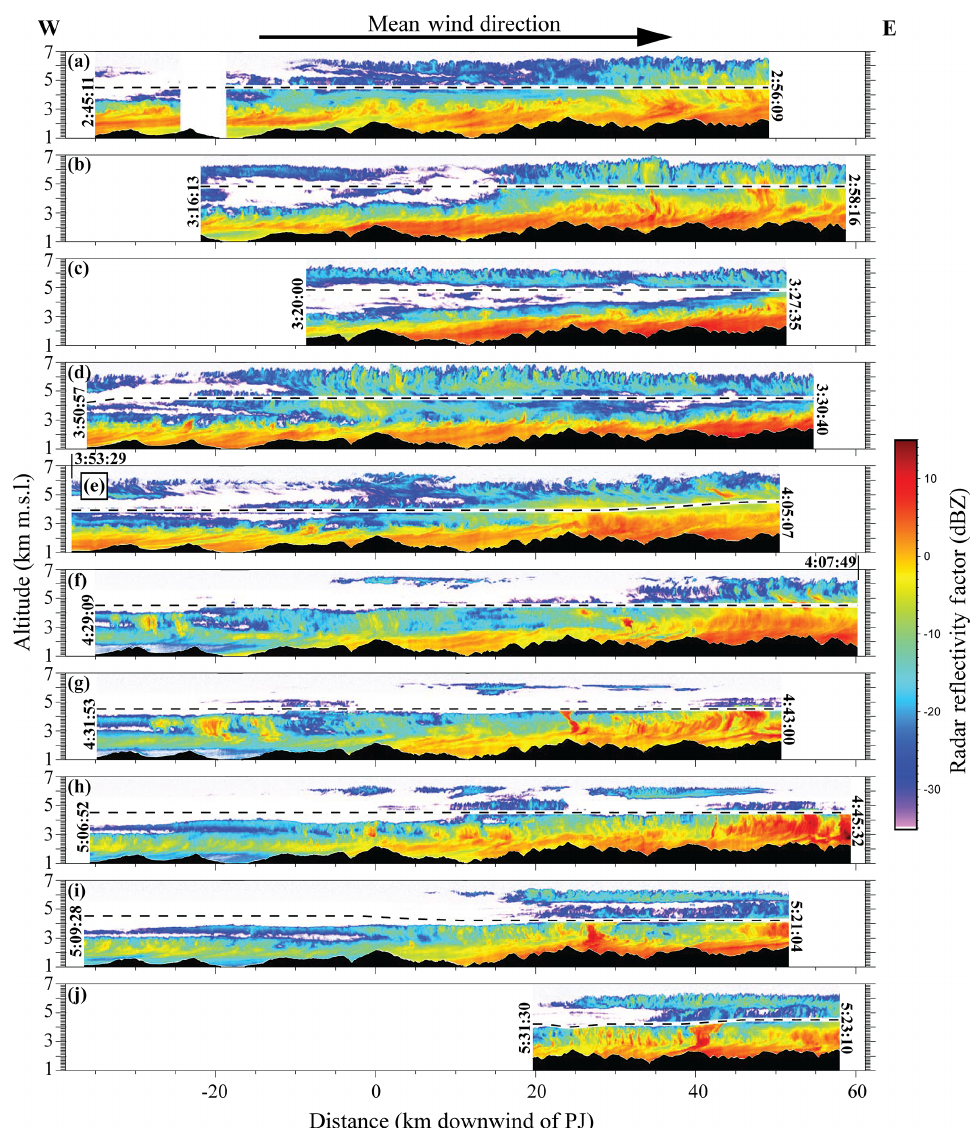
Figure 3. Terrain-referenced W-band radar reflectivity cross sections for all 10 flight legs. All distances are relative to Packer John Mountain, with positive (negative) values downwind (upwind). Leg start and end times are in UTC, with (a) through (j) corresponding to legs 1 through 10,